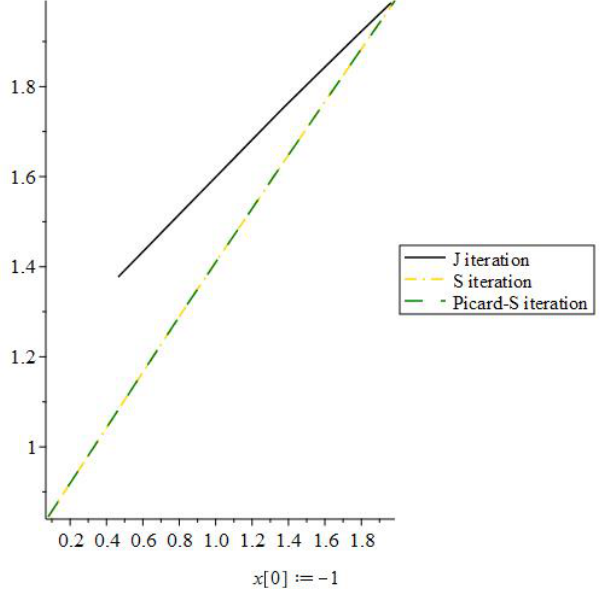
Figure 4. J iteration process convergence when the initial value is −